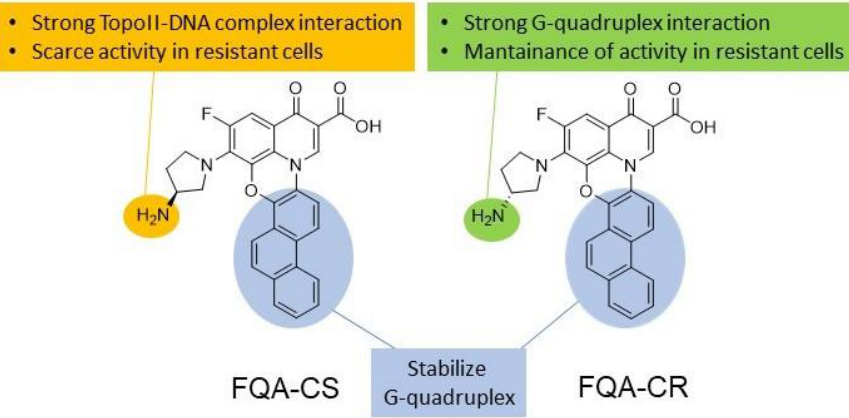
Figure 3. Graphical representation of the fluoroquinoanthroxazines’ functional groups necessary for the interaction with the target proteins.